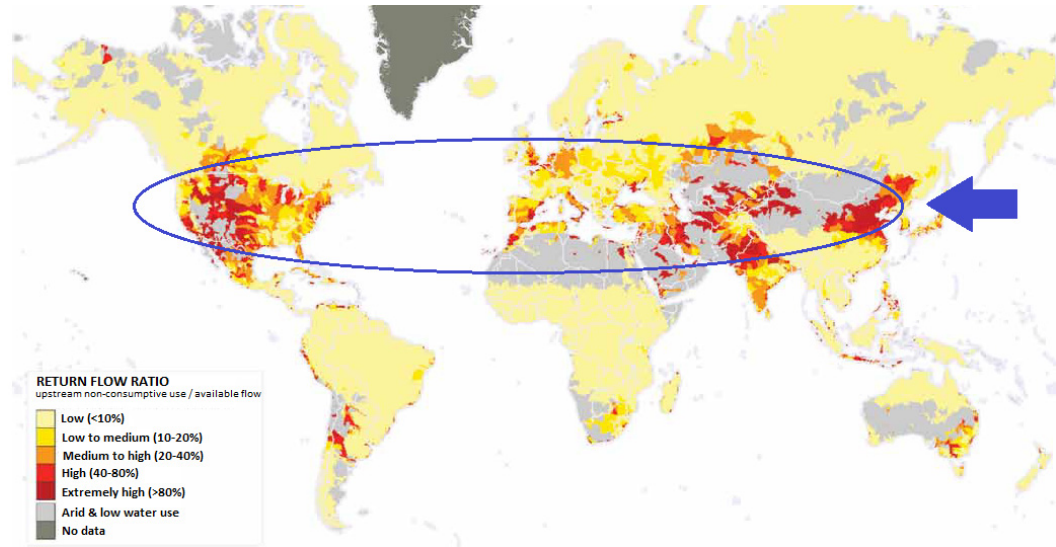
Figure 2. Global return flow ratio, Reproduced with permission from Gassert, F et al., published by city, country, 2005 [7].